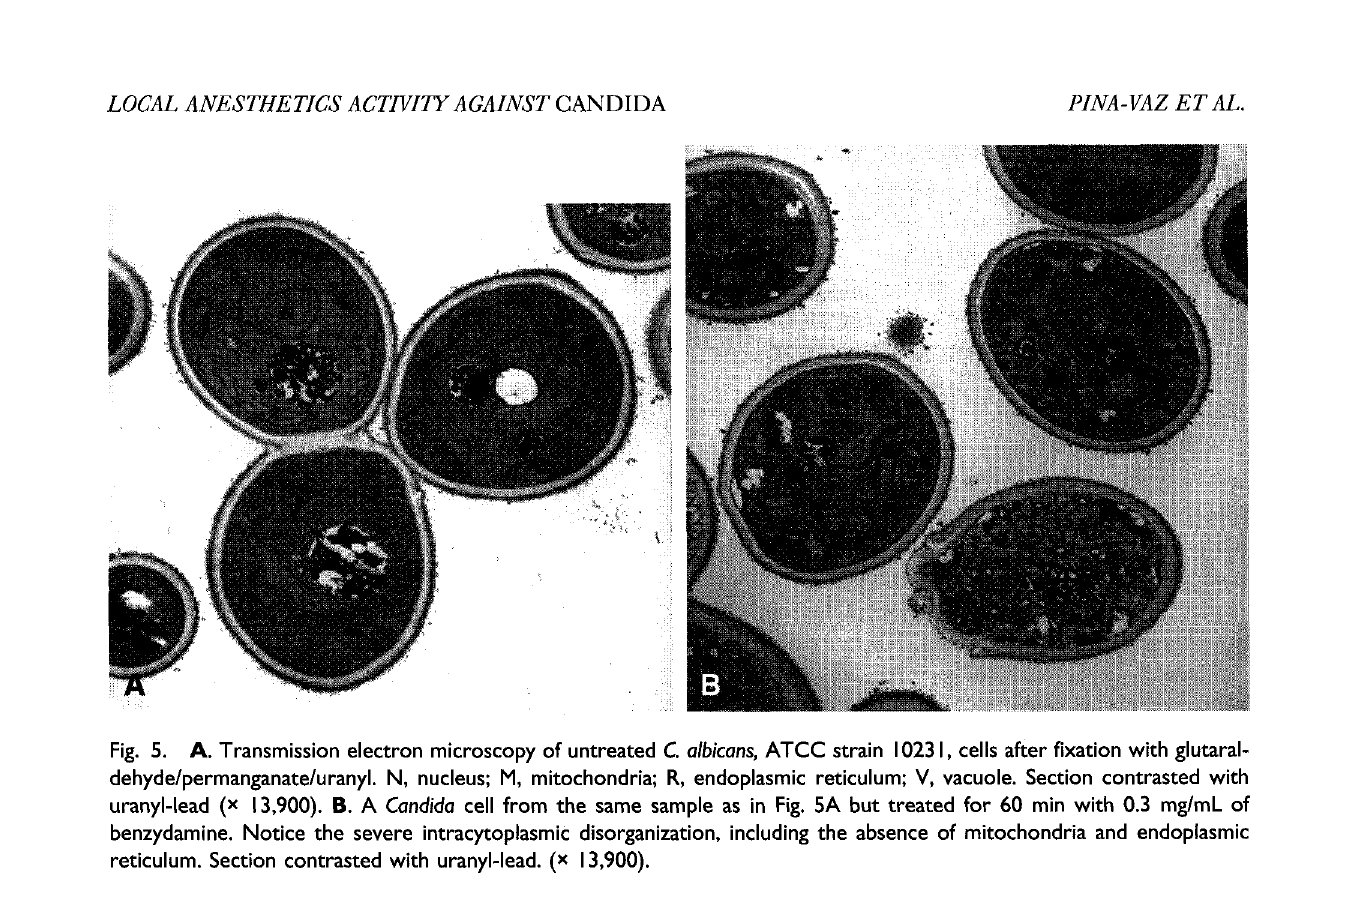
.. Transmission electron microscopy of untreated C. albicans, ATCC strain 10231, cells after fixation with glutaral- Fig. 5. dehyde/permanganate/uranyl. N, nucleus; M, mitochondria; R, endoplasmic reticulum; V, vacuole. Section contrasted with uranyl-lead (x 13,900). B. A Candida cell from the same sample as in Fig. 5A but treated for 60 min with 0.3 mg/ml_ of benzydamine. Notice the severe intracytoplasmic disorganization, including the absence of mitochondria and endoplasmic reticulum. Section contrasted with uranyl-lead. (x